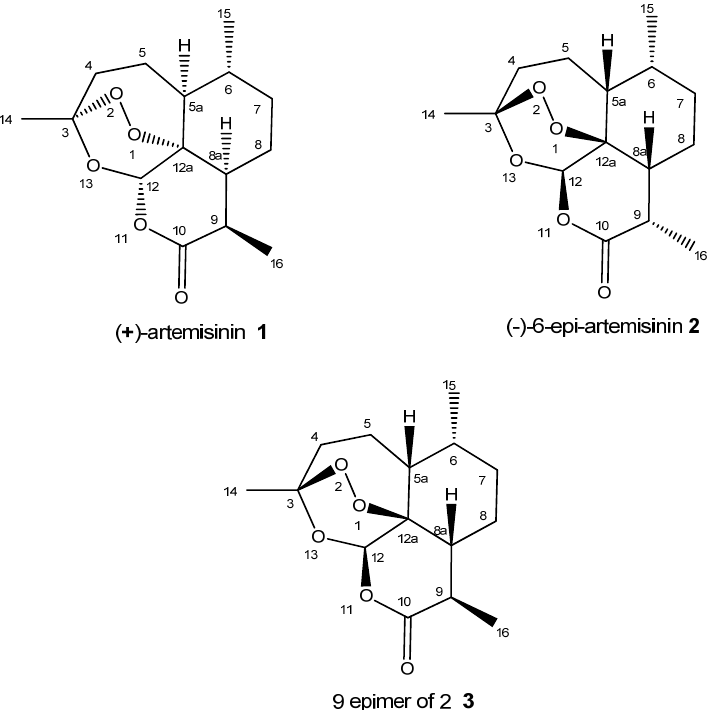
Figure 1. (+) Artemisinin ( 1 ), ( − )-6-epi-artemisinin ( 2 ) and 9 epimer of 2 ( 3